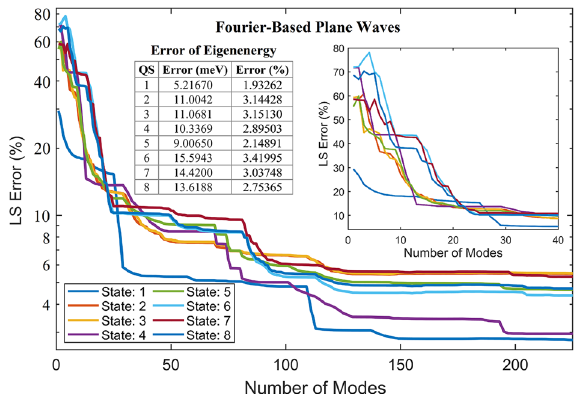
Figure 10. LS errors of WFs in QSs 1–8 for the first 225 modes, resulting from the FPW approach. The insets include a closer look at the LS errors for the first 40 modes and a table of the absolute error of the eigenenergy